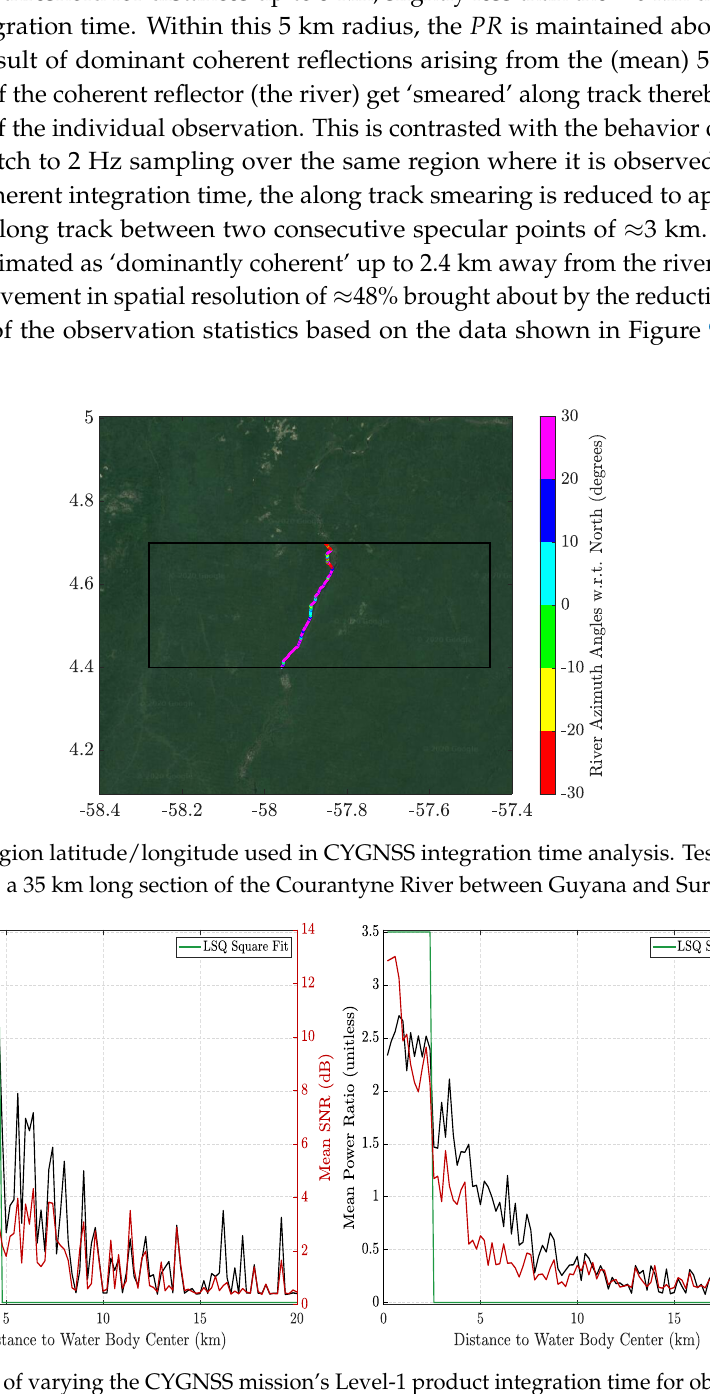
Figure 9. Effects of varying the CYGNSS mission’s Level-1 product integration time for observations in the vicinity of the Courantyne River on the CYGNSS coherence metric and Signal-to-Noise Ratio (SNR) at varying distances from the water body. ( Left ) From 3 July 2018 to 28 February 2019, exclusively comprising 1 Hz data. ( Right ) From 3 July 2019 to 28 February 2020, exclusively comprising 2 Hz data. Green traces indicates Least-Squares estimated transition distance between coherence and non-coherence PR